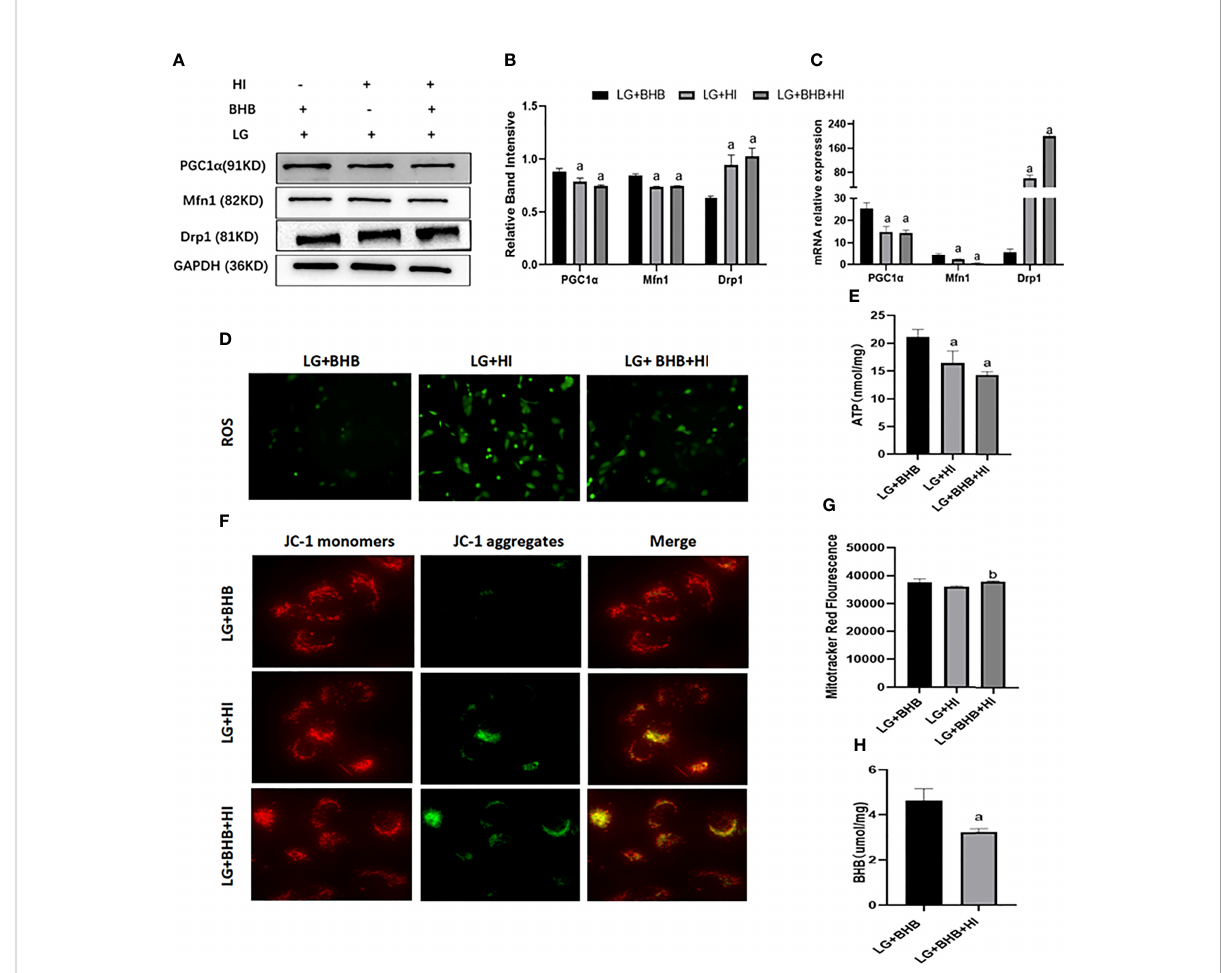
FIGURE 8 Effect of high insulin on BHB induced protection of mitochondria in HK2 cells cultured under low glucose culture. (A) Expression of PGC1 a , Mfn1, and Drp1; (B, C) Quantitative results of protein and gene expression of PGC1 a , Mfn1, and Drp1, respectively; (D – H) Changes of ROS, ATP production, mitochondrial membrane potential, the mitochondrial number changes, and intracellular BHB content. a p < 0.05, compared with the LG+BHB group; b p < 0.05, compared with the LG+HI